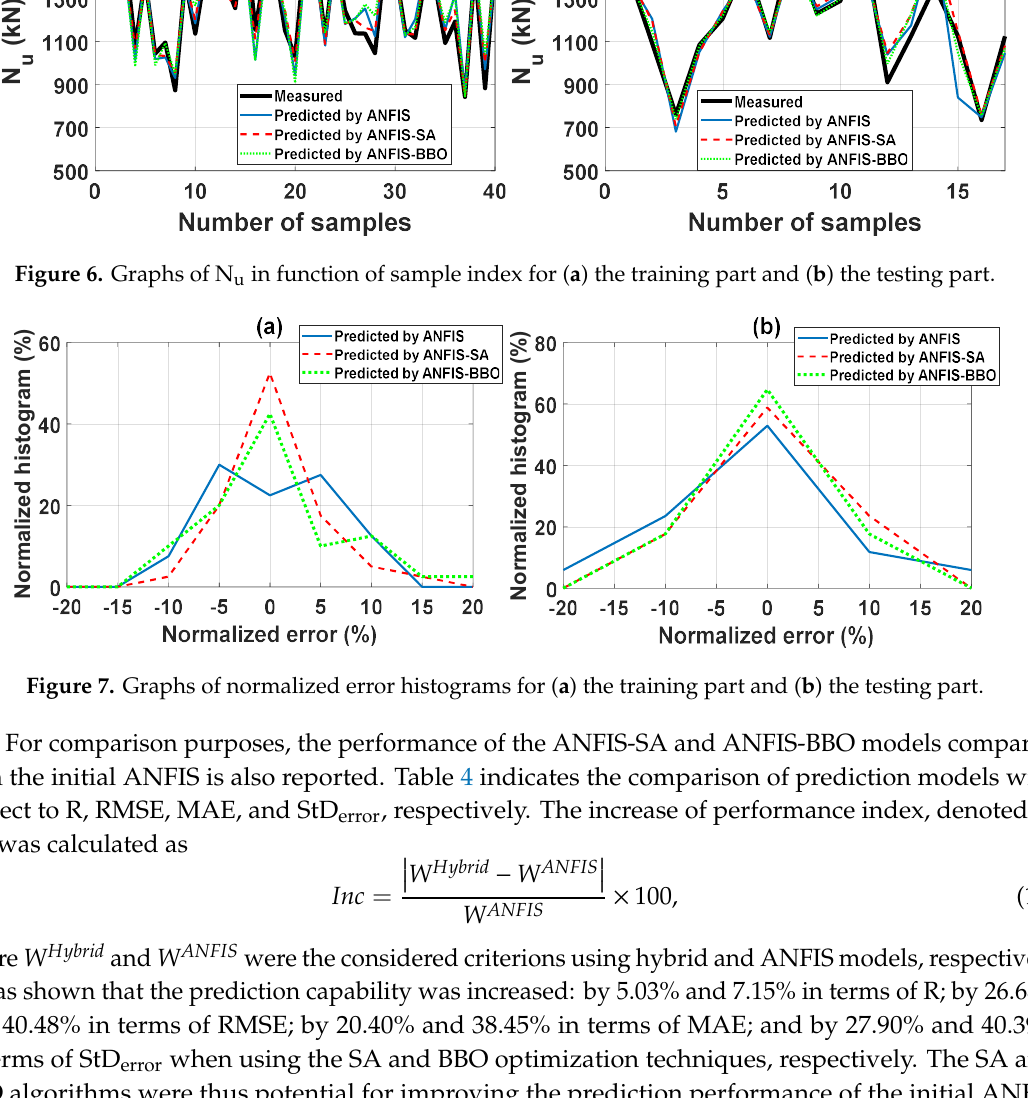
Table 4. Increase of performance index Inc (in %) using hybrid